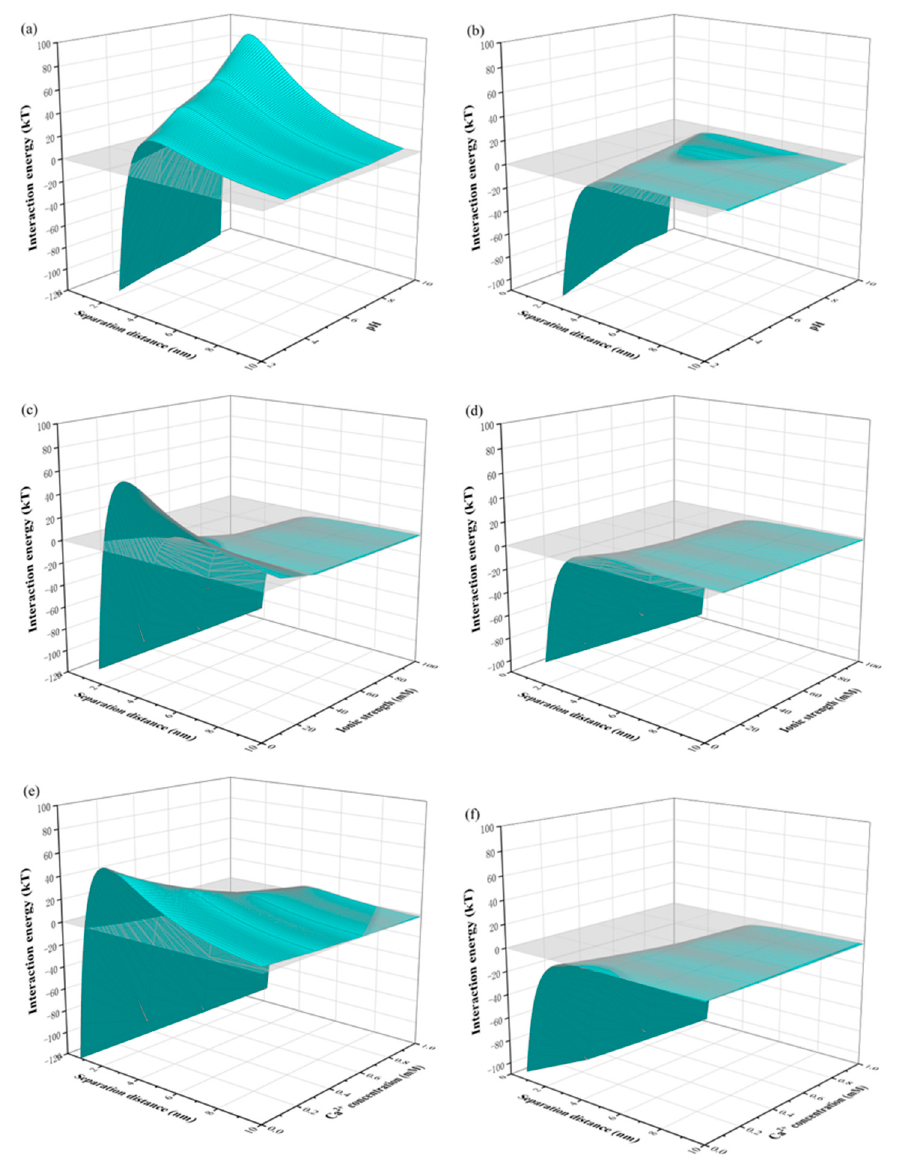
Figure 3. Profiles of the total interaction energies of membrane–foulant and foulant–foulant combinations with separation distance under different solution conditions: ( a , b ) pH, ( c , d ) IS, and ( e , f ) Ca 2+ concentration.